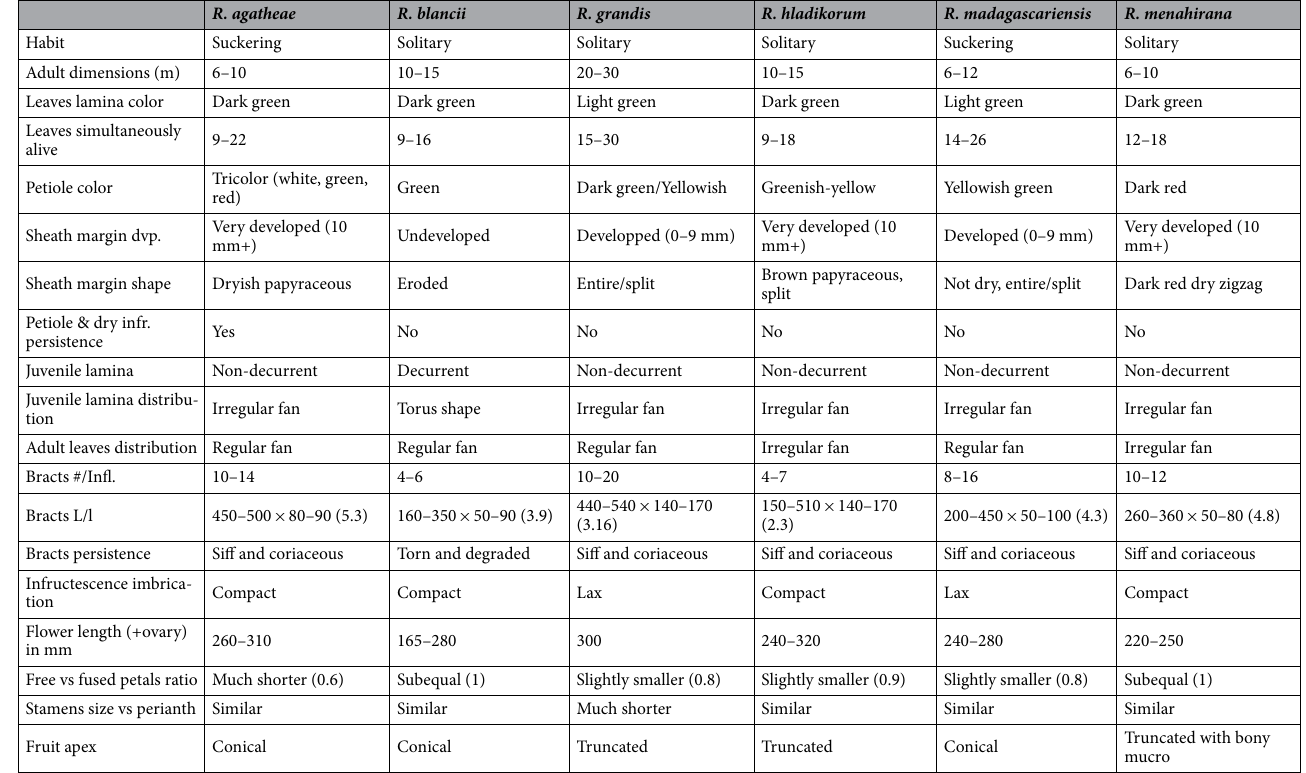
Table 1. Comparison of the main distinctive morphological characters for the six species of Ravenala